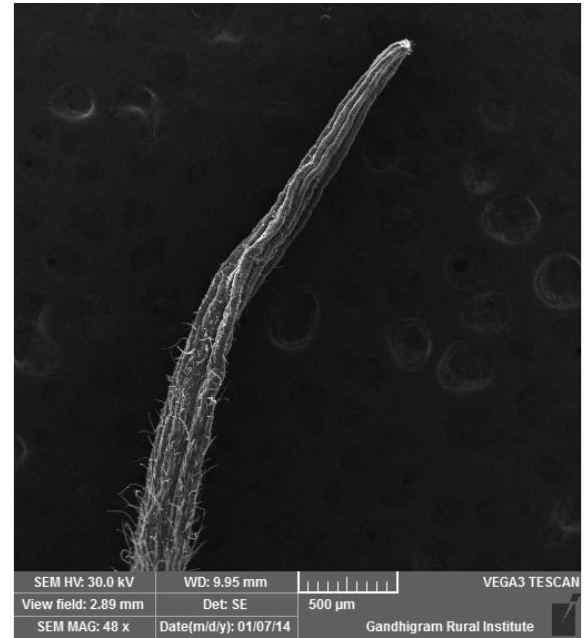
Image 1f. SEM of anthers